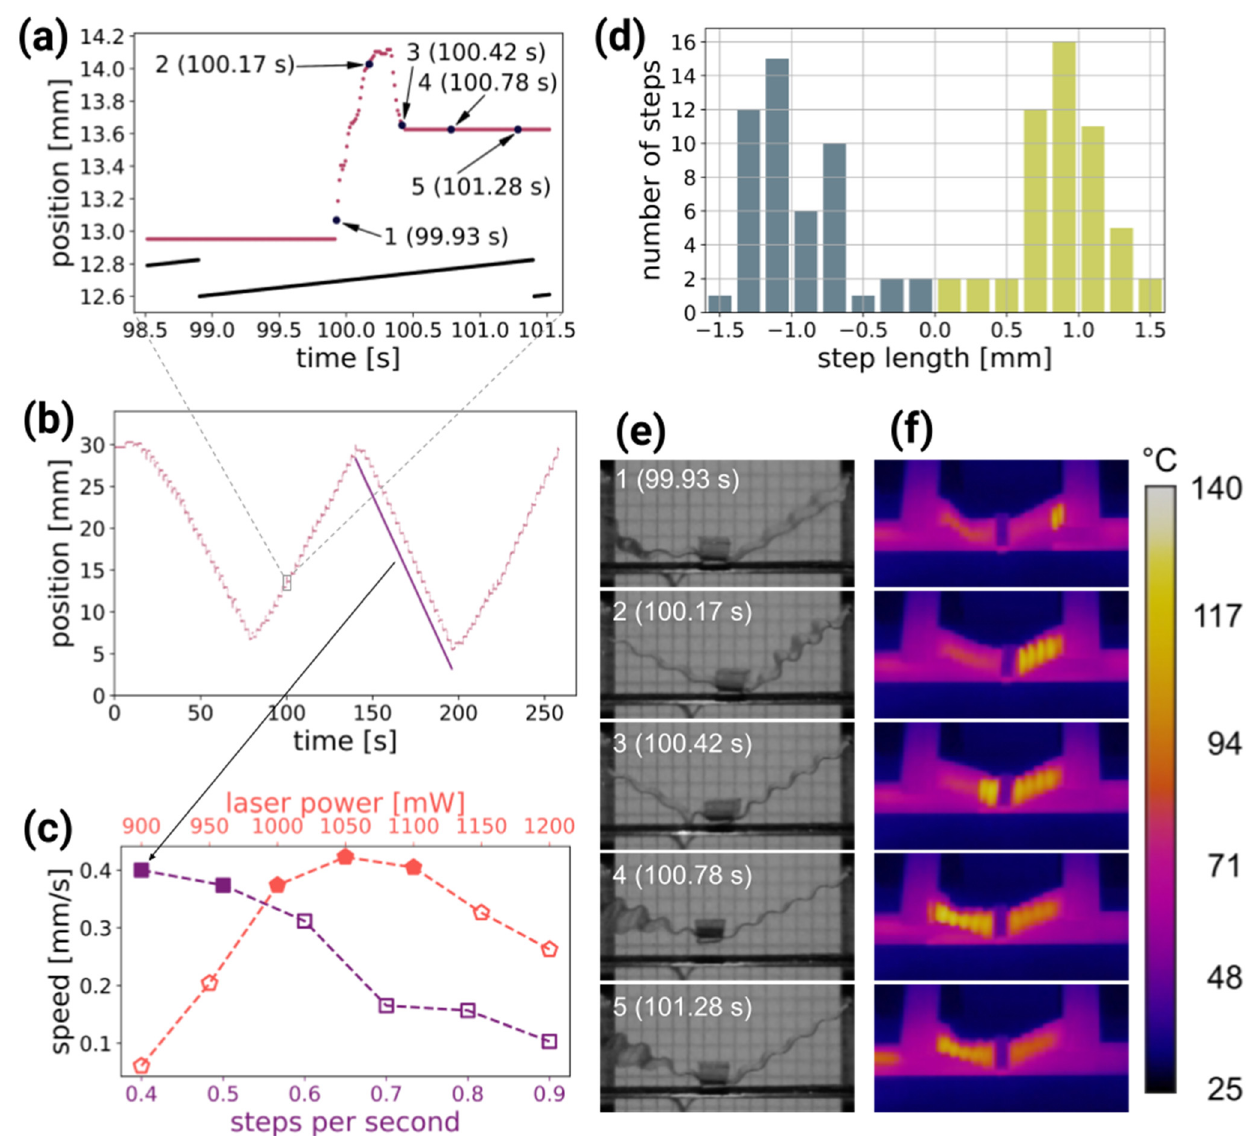
Figure 3. Performance of the light-driven linear inchworm motor: ( a ) horizontal position of the shaft during one laser scanning cycle (red points) and the laser beam scanning galvo signal (black line). The numbers correspond to the positions in the photographs in ( e ). ( b ) The shaft position versus time for continuous operation of the motor, with the scanning direction changed three times. The average shaft speed is measured by fitting straight lines (purple line) to the position over many steps. ( c ) The motor average speed for different scan frequencies and laser powers. Filled symbols represent the parameters where repeatable, linear motor operation was achieved, while open symbols represent parameters where stable operation was not possible (see text for details). ( d ) Step length histogram of the measurement presented in ( c ). The motor operation during one cycle recorded with visible ( e ) and infrared ( f ) camera. A triangular marker is visible, attached at the bottom of the shaft, that was used for position tracking. Scan parameters in ( a – e ): 0.4 steps per second, 1 W laser power.